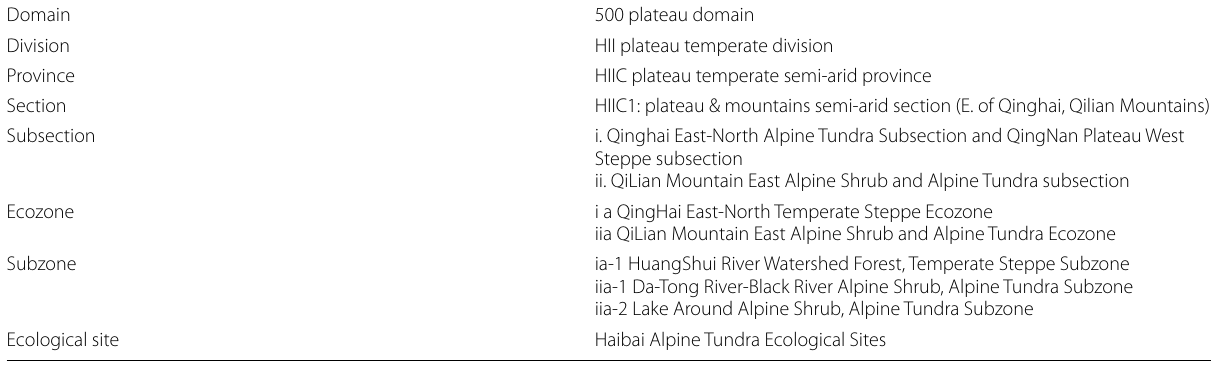
Table.3 An integrated ecosystem classification of the North-Eastern Qinghai province in China Domain